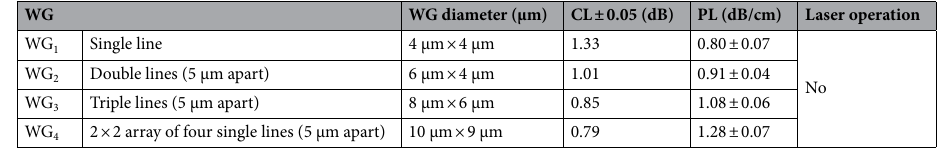
Table 1. PL and CL through 100 kHz, 200 nJ written WGs at 1550 nm wavelength. FL for the Yb 3+ :GPGN glass is (0.73 ± 0.05) dB. PL is the WG PL calculated from TL using PL = TL/d where d = 1.05 cm is the length of the